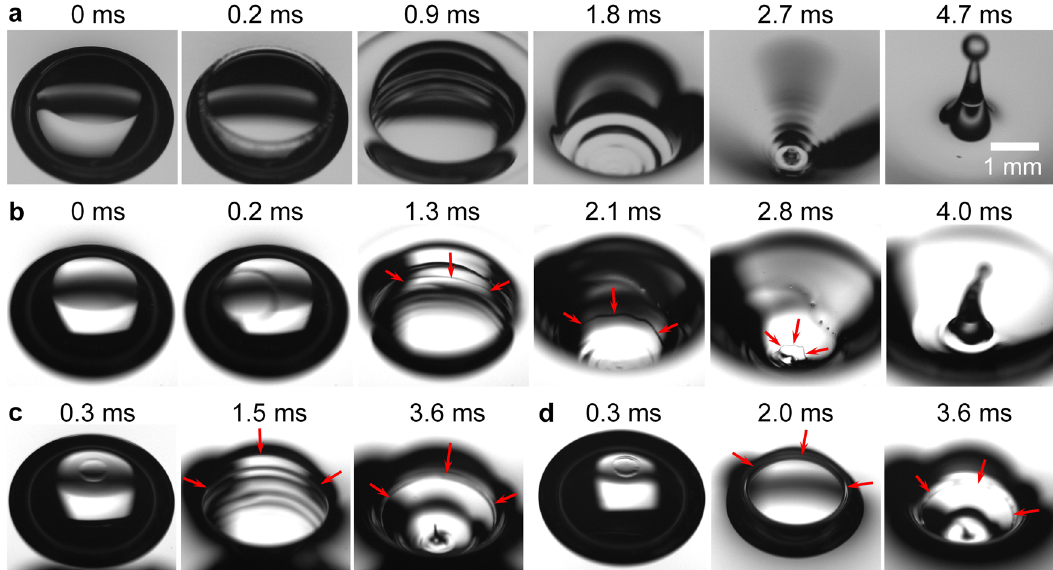
Fig. 3 Top-view snapshots of oil spreading on the cavity surface during bubble bursting at the aqueous surface. The water surfaces shown here are ( a ) clean, and covered by a layer of ( b ) 100 cSt silicone oil, h / R = 0.8, ( c ) 1000 cSt silicone oil, h / R = 0.8, and ( d ) 1000 cSt silicone oil, h / R = 1.2. Scale bar = 1 mm. Comparing with the pure water case ( a ), a macroscopic oil edge (marked by red arrows) along the cavity after the cap rupture at an oil- covered aqueous surface is clearly observed, which is generated by oil spreading in the complete-wetting state ( b – d ). The macroscopic oil edges can be distinguished since they typically show asymmetric and irregular morphology, while the capillary waves from cavity collapse show axisymmetric and smooth patterns. Additional evidence is shown in Supplementary Fig. 5 with tracer particles to assist visualization of the macroscopic oil